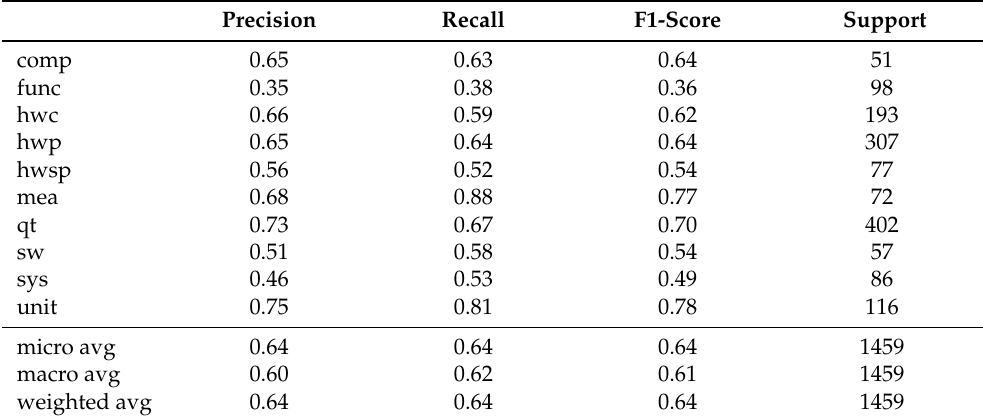
Table 5. Classification